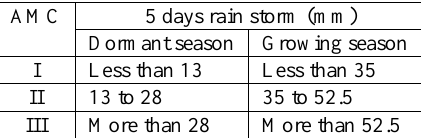
Table 1. Antecedent moisture conditions AMCs for determining